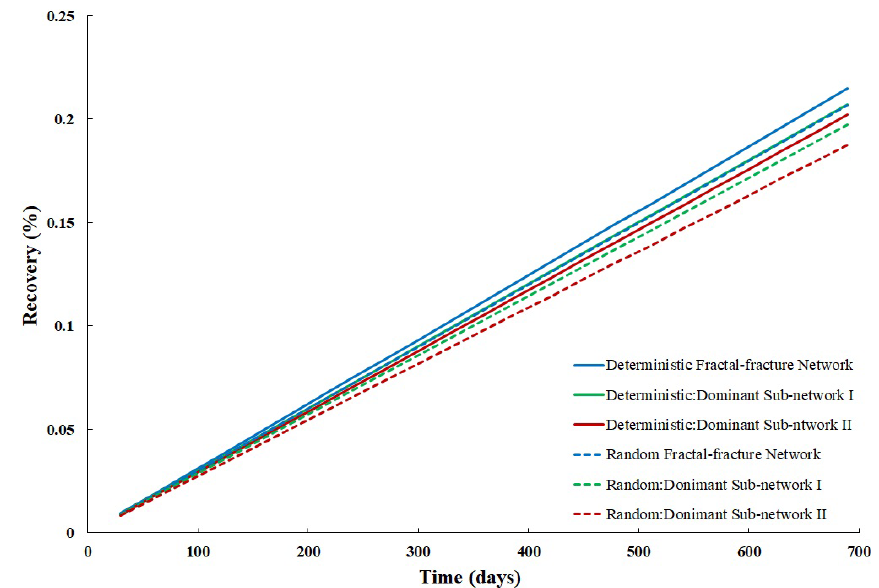
Figure 5. Recovery curves of deterministic and random fractal-fracture networks along with their respective dominant sub-networks. Table 3. Overall fluid recovery values of different fracture networks and their dominant sub-networks. Overall Recovery Deterministic Random Natural Fractal-Fracture Map Fractal-Fracture Map Fracture Map Parent Network 0.2372 Dominant Sub-Network-I 0.2272 0.1934 Dominant